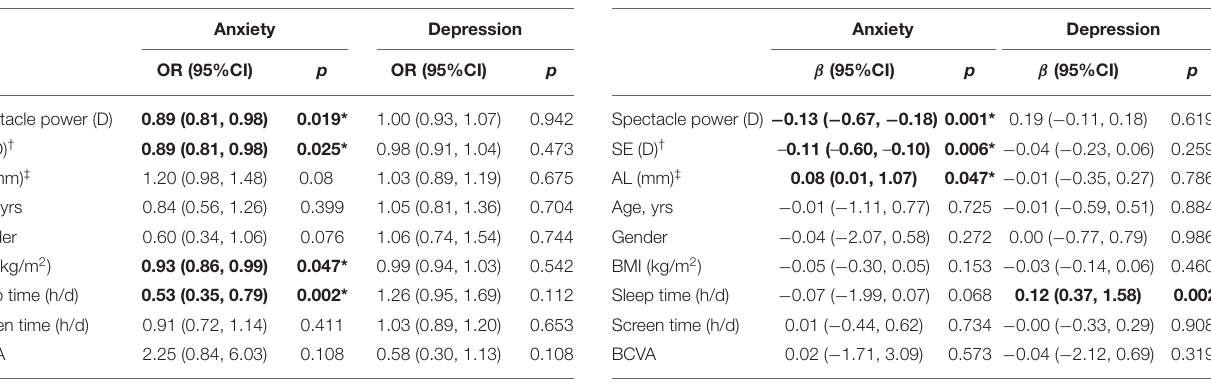
TABLE 3 | Associations of demographic, lifestyle and vision characteristics with anxiety, and depression score ( n = 764).